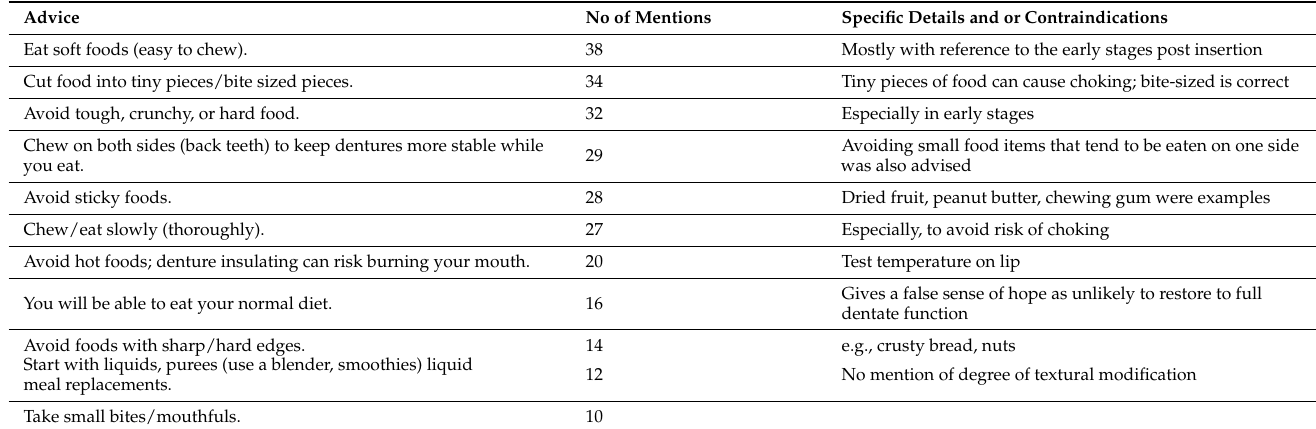
Table 3. Summary of recommendations for dietary intervention in people who wear dentures, identified from the Google